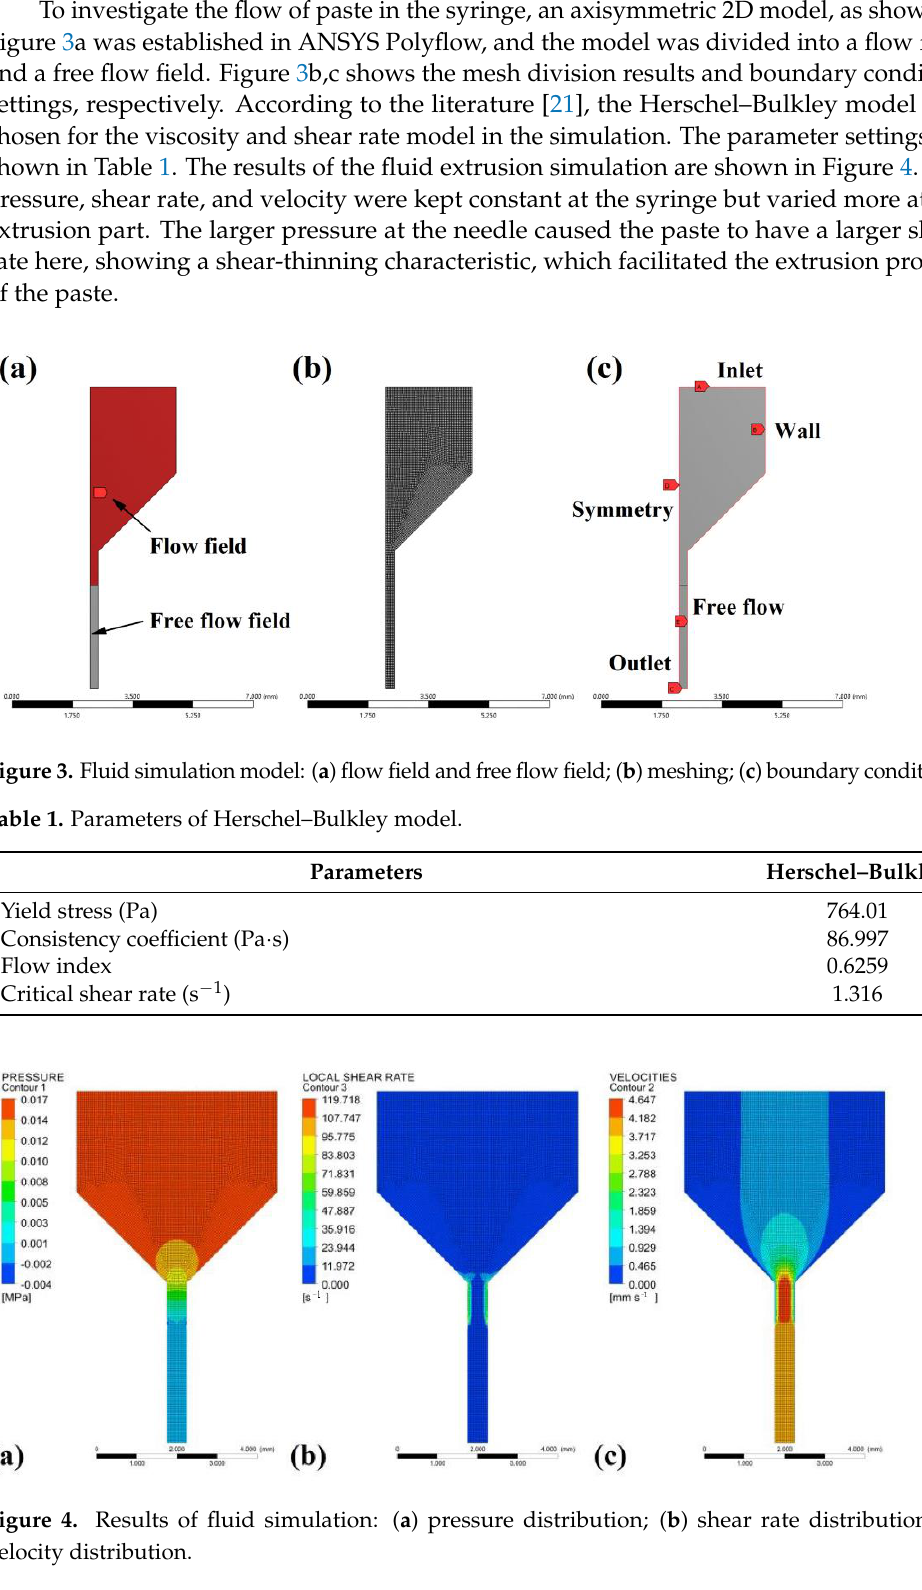
Table 1. Parameters of Herschel – Bulkley model.